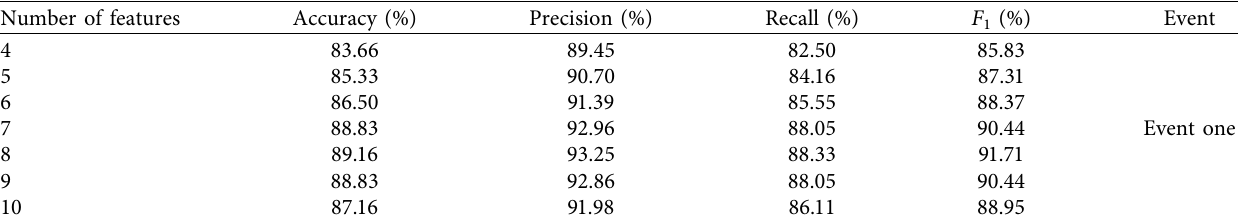
Table 7: Model performance with different indicators in event one.